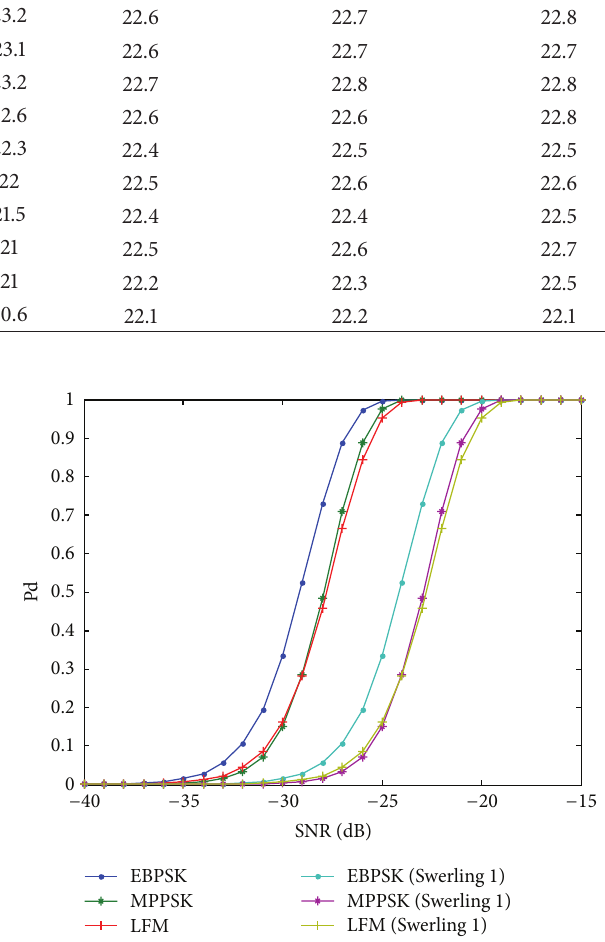
Figure 5: CFAR target detection probability comparisons for V = 750